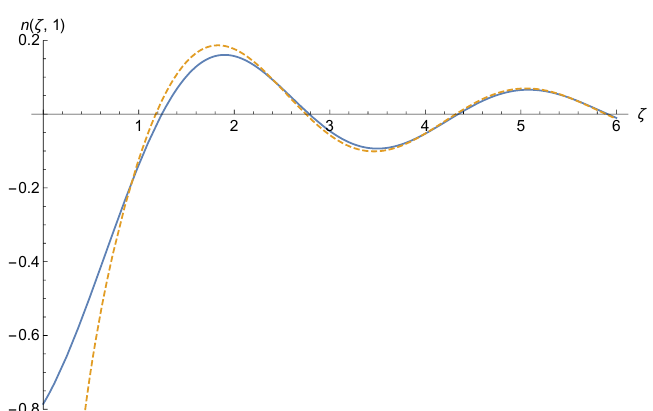
Figure 4: The relative change in the density around the point x = x (71) due to a repulsive delta function potential at the point x = 0 of amplitude λ = γ k for γ = 1 (solid line), and its asymptotic approximation (dashed line) R F obtained using Eq.